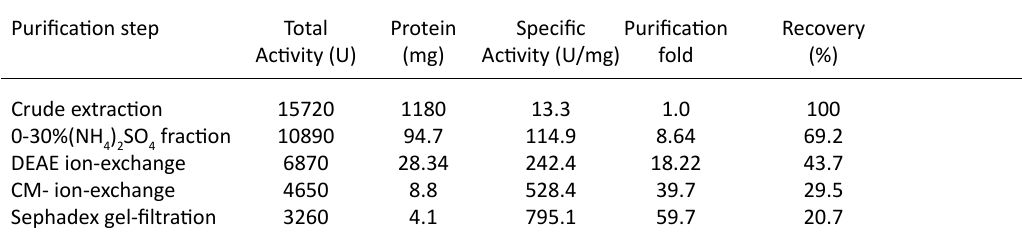
Fig. 1. SDS-PAGE Gel of the purified LKE-021 Table 1. Separation of lke-021 esterase Purification step Total Protein Specific Purification Recovery